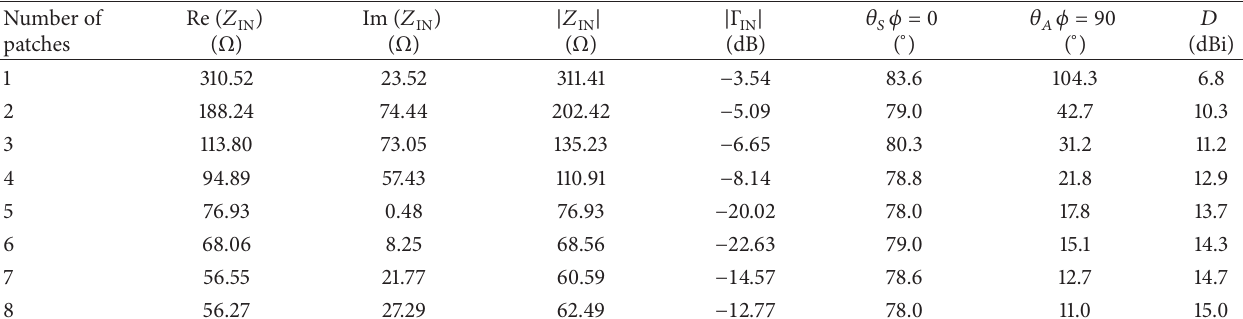
Table 1: Synthesis of simulation results for serial array with 1 to 8 patches.